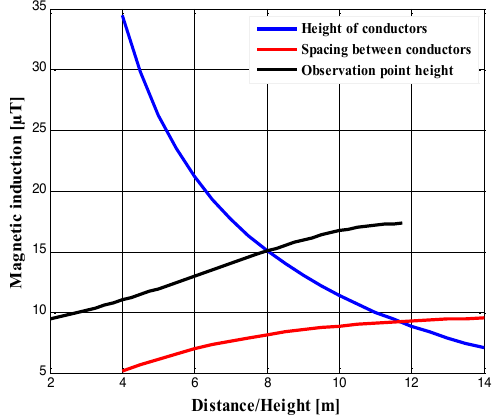
Figure 15: Magnetic induction profile at 1 m above ground level as a function of the conductor height, the spacing between two phases and observation point height.